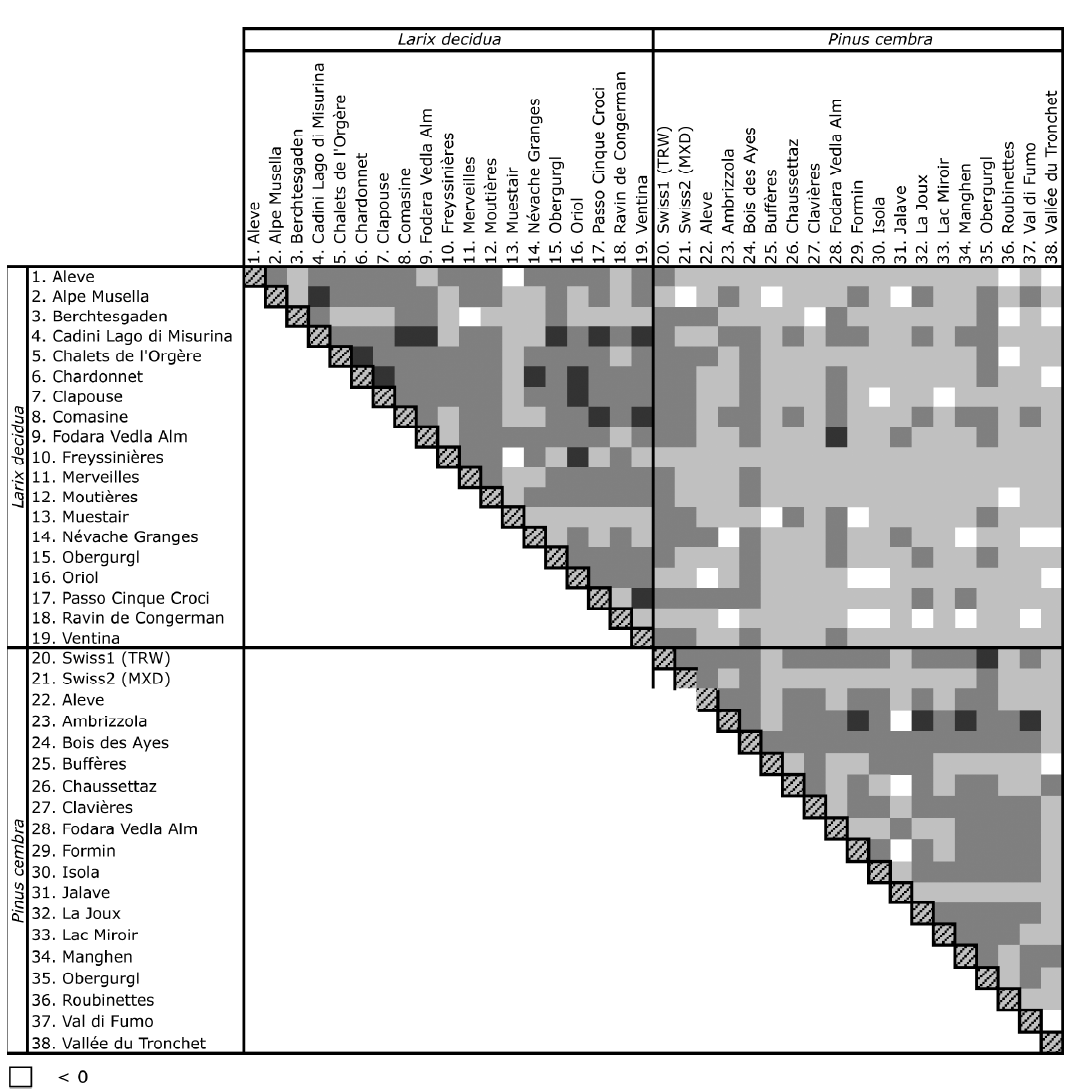
Table 2. Correlation matrix of the Adaptative Regional Growth Curve detrended chronologies (1637-1974 period).